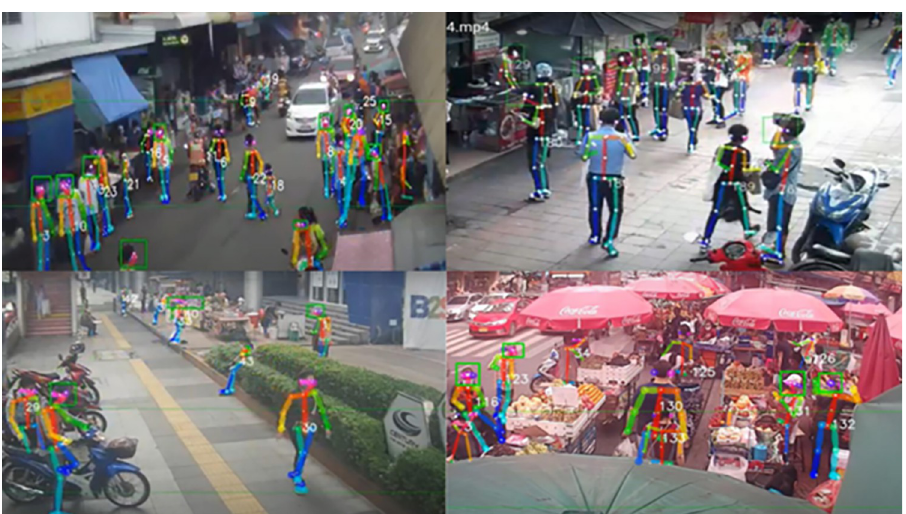
Fig 2. Sample of debugged images for validating